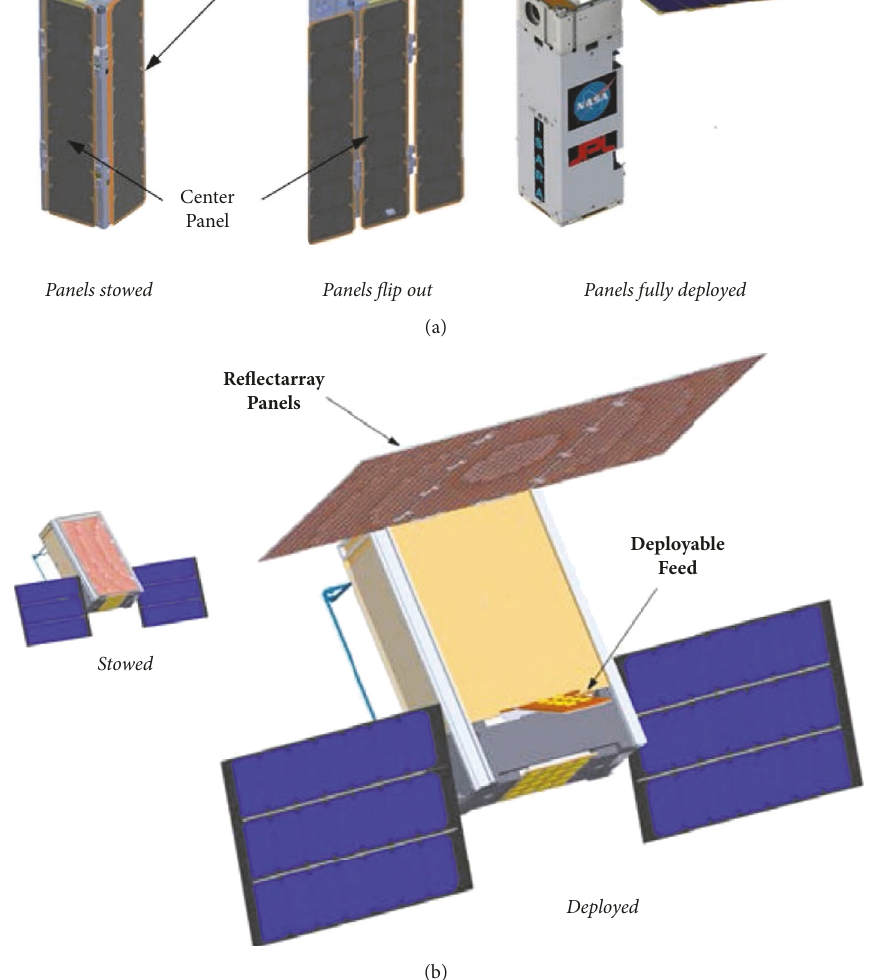
Figure 6: (a) ISARA CubeSat [72]. (b) MarCO CubeSat [73].